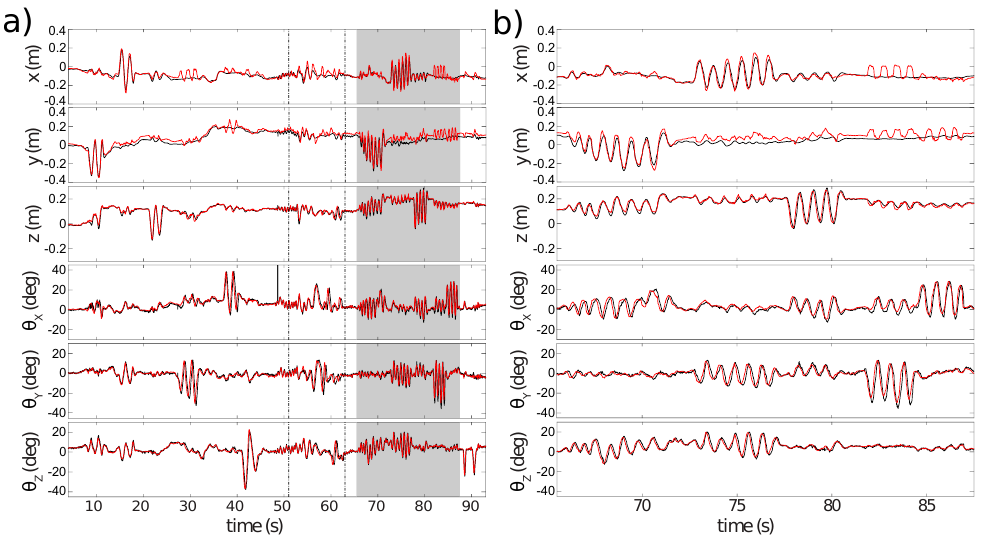
Figure 8. Comparison between pose estimates generated by ESPEE (red) and ground truth generated by the Vicon motion capture system (black). ( a ) The full 93 s sequence. Vertical lines indicate where room lighting was switched off (51 s) and on again (63 s). The shaded region shows a period of rapid motion which is magnified in ( b ). ESPEE performs well, but ambiguities between rotations and translations are visible between 82 and 87